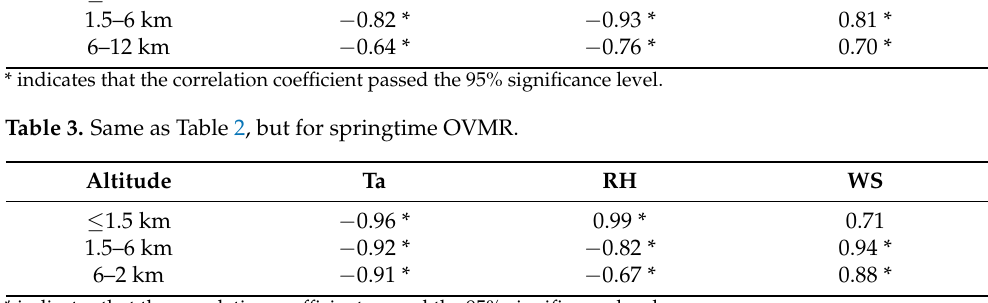
Table 3. Same as Table 2, but for springtime OVMR.